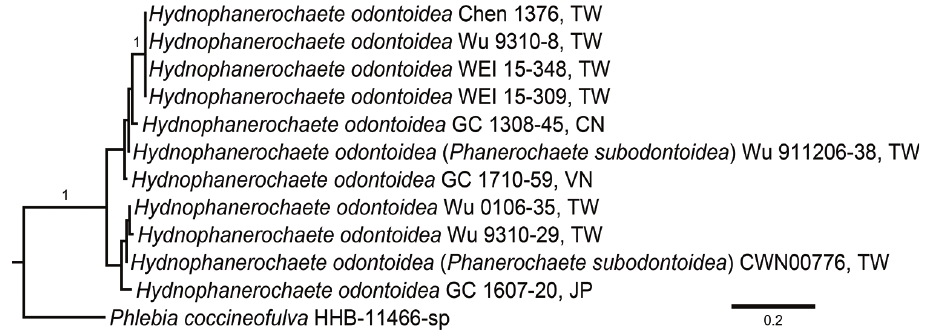
Figure 2 . The majority-rule consensus phylograms of the Bayesian Inference analysis of the ITS se- quences of Hydnophanerochaete odontoidea . Nodes are labelled with Bayesian Posterior Probabilities ≥ 0.9. Scale bars = substitutions per